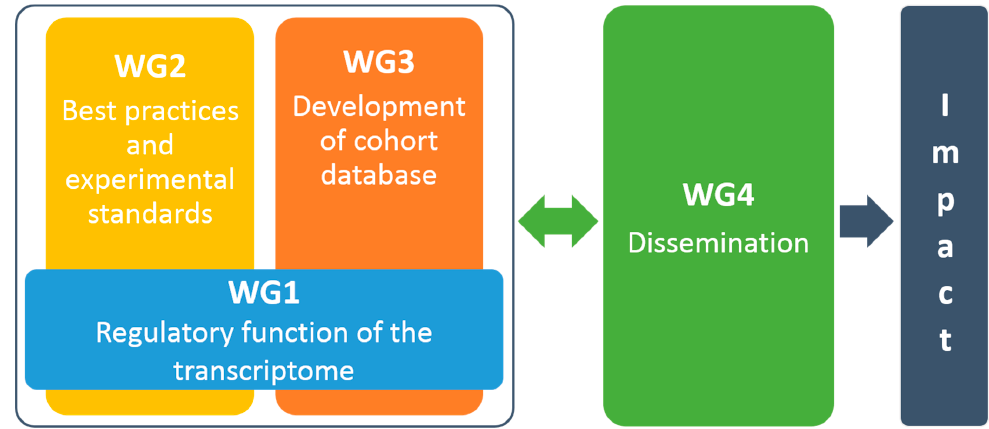
Figure 3. Overall interrelations between the four CardioRNA working groups (WGs) created to achieve the goals described.